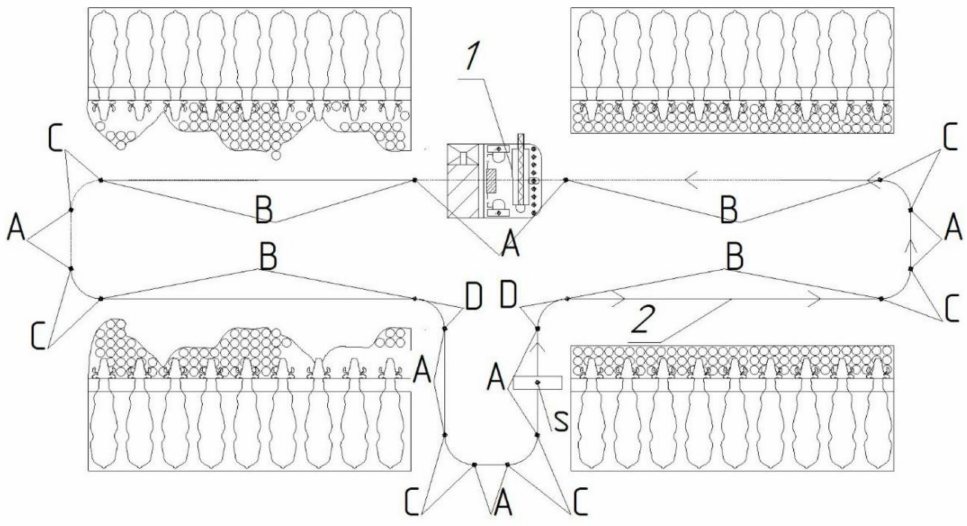
Figure 2. Schematic diagram of the pusher robot travelling along the cattle farm. 1—pusher robot, 2—robot movement